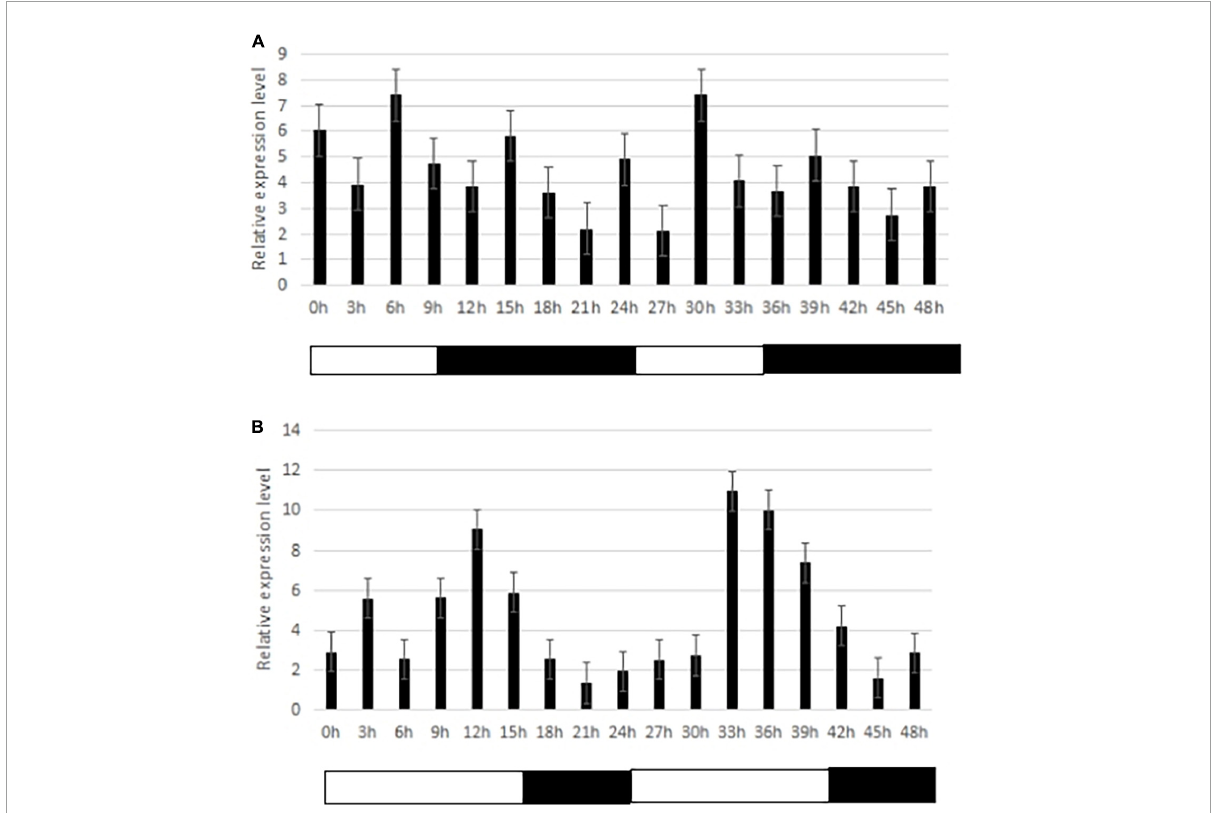
FIGURE5 Circadian expression of the candidate gene SiCOL5 under different photoperiod treatments. (A) Short-days; (B) long-days. Black bars represent the dark period, and white bars represent the light